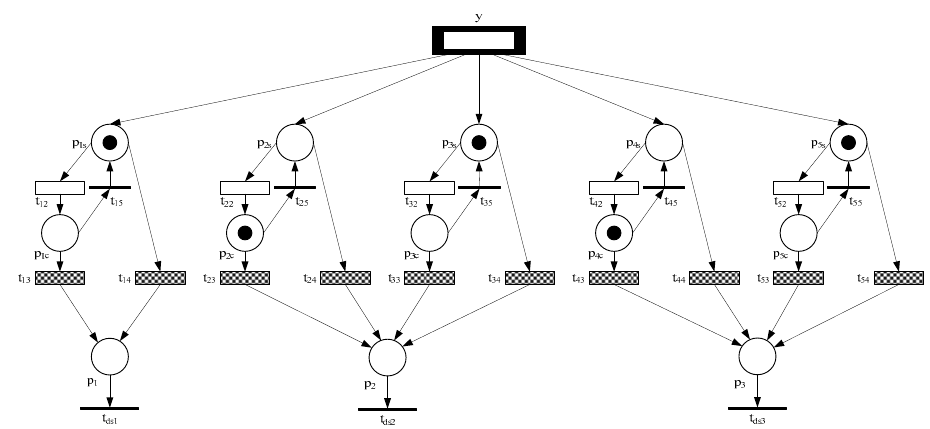
Figure 8. PN model for a system with five charging tanks and three distillers.